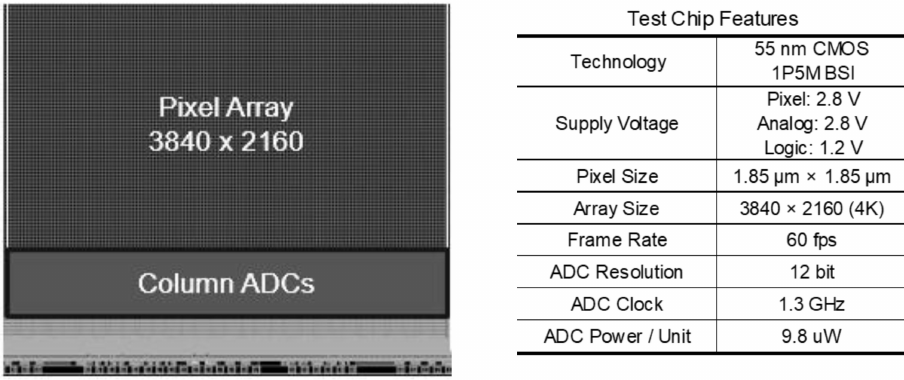
Figure 15. Test chip